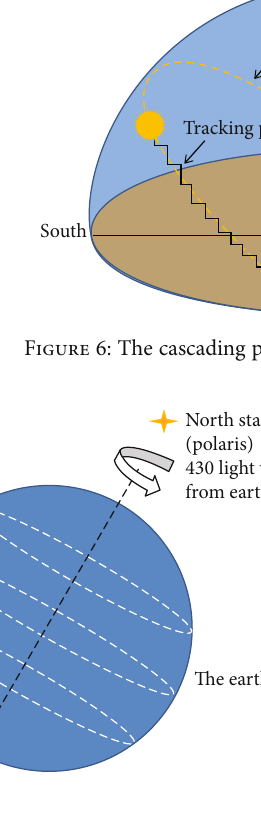
Figure 7: The solar panel tracking axis is parallel to the earth ’ s axis of